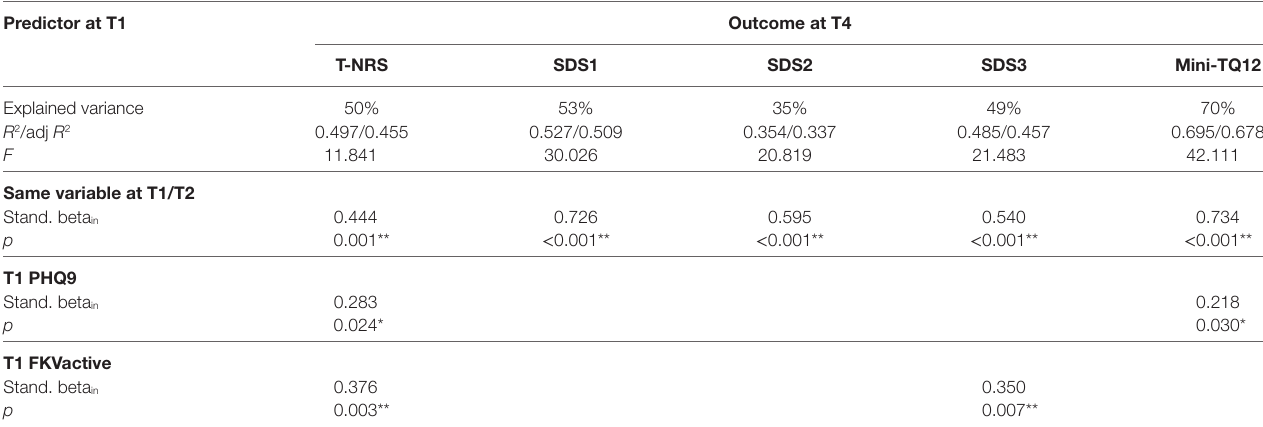
TaBle 6 | Results of step-wise regression analysis.